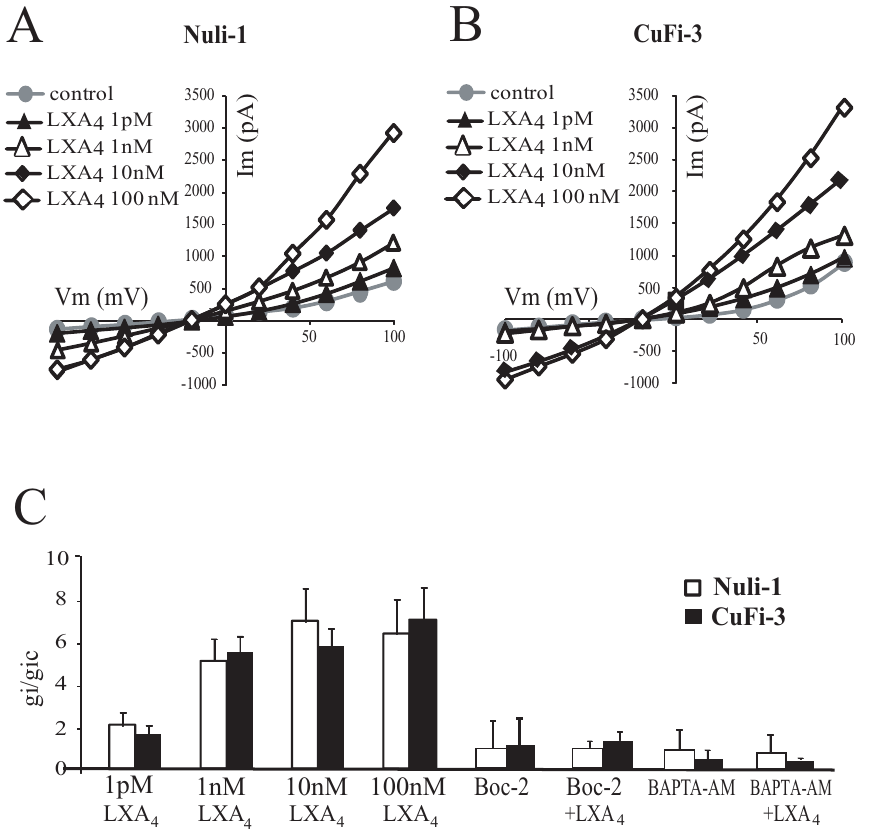
Figure 4. Dose dependency of the effect of LXA 4 on whole-cell currents of normal (Nuli-1) and CF (CuFi-3) bronchial epithelial cell lines. Typical I-V relationships obtained before and after 10 min exposure to 1 pM (n=6 Nuli-1, n=6 CuFi-3), 1 nM (n=4 Nuli-1, n=4 CuFi-3), 10 nM (n=3 Nuli-1, n=3 CuFi-3) and 100 nM (n=6 Nuli-1, n=6 CuFi-3) LXA 4 in Nuli-1 (A) and CuFi-3 (B) cell lines. (C) Mean inward conductance changes normalized to control values (gi/gic obtained without LXA 4 ) as a function of LXA 4 concentration in Nuli-1 (open bars) and CuFi-3 (black bars) cells in control conditions and obtained upon exposure to Boc-2 (10 m M) alone (10 min, 100 nM, n=4 Nuli-1, n=4 CuFi-3) or with Boc-2 (10 m M) and LXA 4 (10 min, 100 nM, n=6 Nuli-1, n=6 CuFi-3) and after BAPTA-AM pre-treatment alone (n=6 Nuli-1, n=6 CuFi-3) or with BAPTA-AM and LXA 4 (10 min,